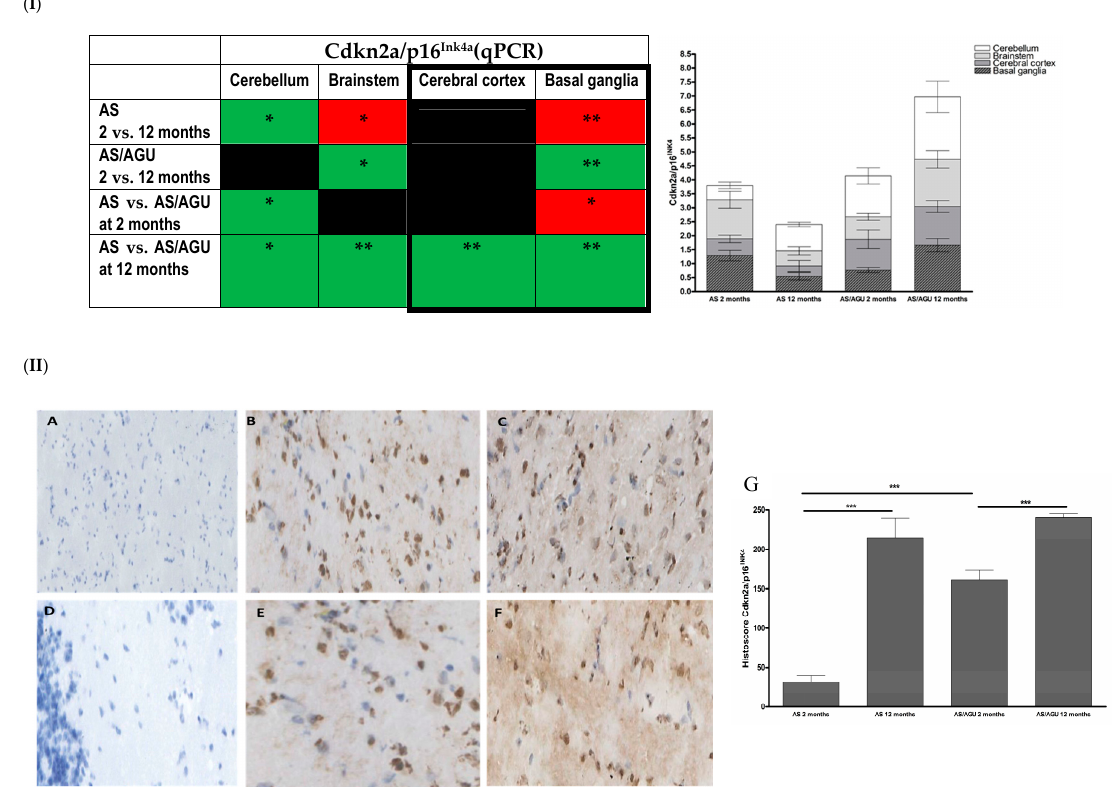
Figure 2. Age-related differences in Cdkn2a/p16 Ink4a expression in the brains of AS and AS/AGU rats. ( I ) Cdkn2a/p16 expression measured using qPCR. ( I ) Directionality of transcriptional changes denoted as colours (green-increase and red decrease in relative gene expression). Black colour denotes lack of significant changes in the gene expression. Regions of the brain linked to Parkinson’s disease are bolded for easier comparison). Stacked bar chart represents mean RQ Cdkn2a/p16 Ink4 with SEM for each individual brain region in both rat strains at the two time points. Each bar represents the mean with SEM for an individual category. ( II ) Immunohistochemical staining and total histoscore for p16 Ink4a protein expression (brown precipitate) in para-sagittal brain sections collected from two month and 12 month old AS and AS/AGU rats. A : negative control (AS at 12 months old). B : Two month old AS. C : Twelve month old AS. D : Negative control (AS/AGU at two months old). E : Two month old AS/AGU. F : Twelve month old AS/AGU. G : Corresponding histoscores for p16 Ink4a expression in 12 month old AS and AS/AGU rats. Significance: * p < 0.05, ** p < 0.01, *** p <